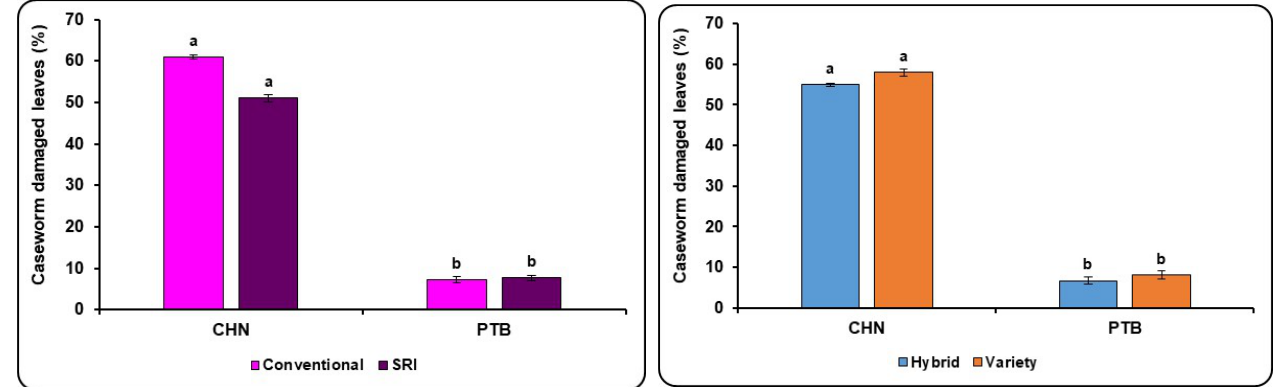
Figure 4. Leaf folder incidence with different methods of rice cultivation and cultivars. Means with the same letter are not significantly different by Tukey’s HSD ( p = 0.05) at each location. Caseworm incidence was also observed at two locations where it was at par with both cultivation methods and across cultivars (Figure 5). Gall midge incidence was observed at two locations, and the highest damage was observed at Ragolu in hybrid rice with both cultivation methods (Figure 6). The damage was on par in both methods of rice cultivation.